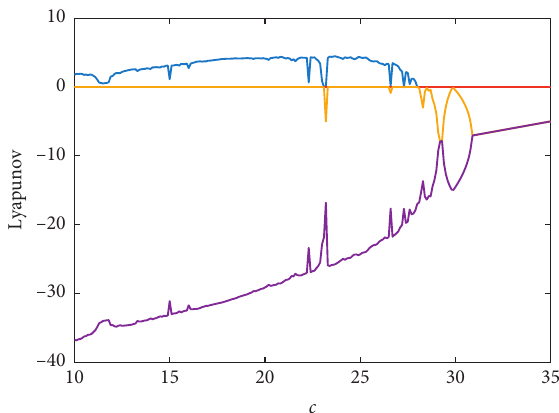
Figure 9: Bifurcation diagram corresponding to c . Table 2: Under different system parameters c , the system is in different